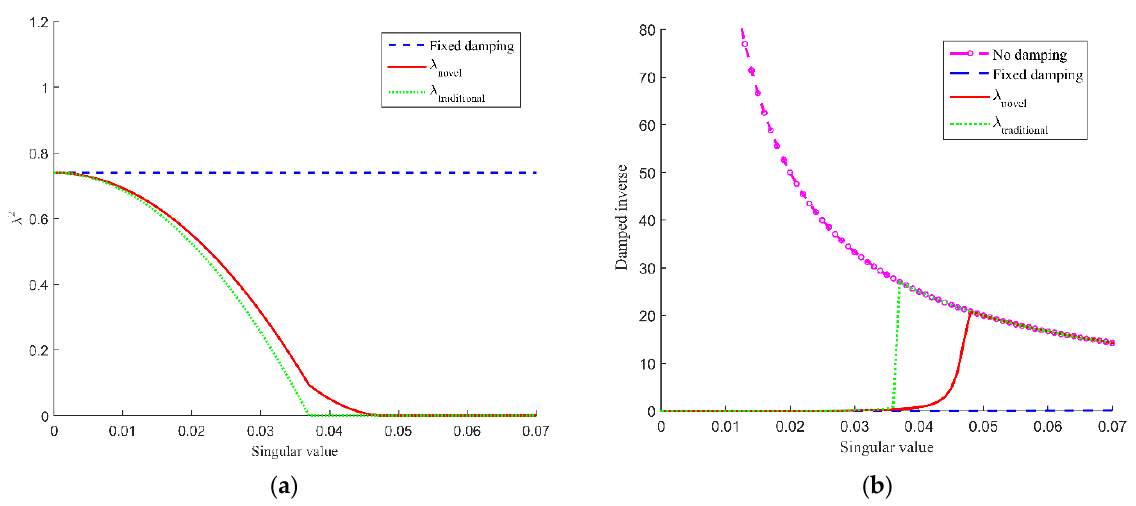
Figure 3. Distributions of damping factor ( a ) and damped inverse ( b ) with singular value, the example shows λ max = 0.86, σ b = 0.038, γ =